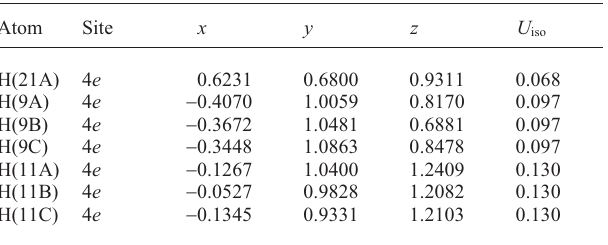
Table 2. Atomic coordinates and displacement parameters (in Å 2 )